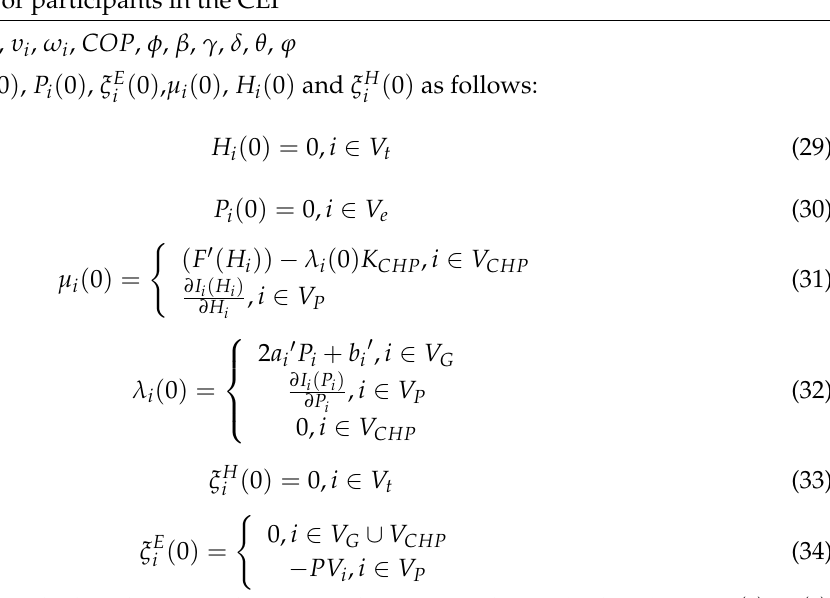
Algorithm 1 Algorithm for participants in the